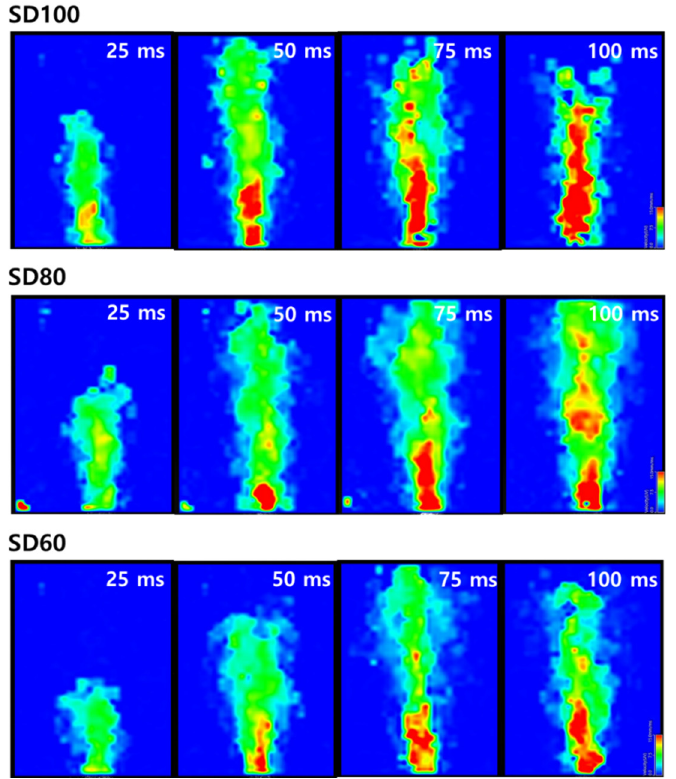
Figure 7. Contour images of particle flow field emitted from DPIs.